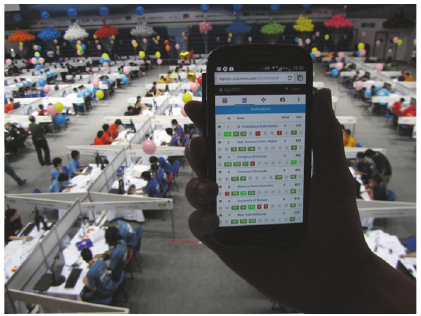
Figure 21: Real-time scoreboard in